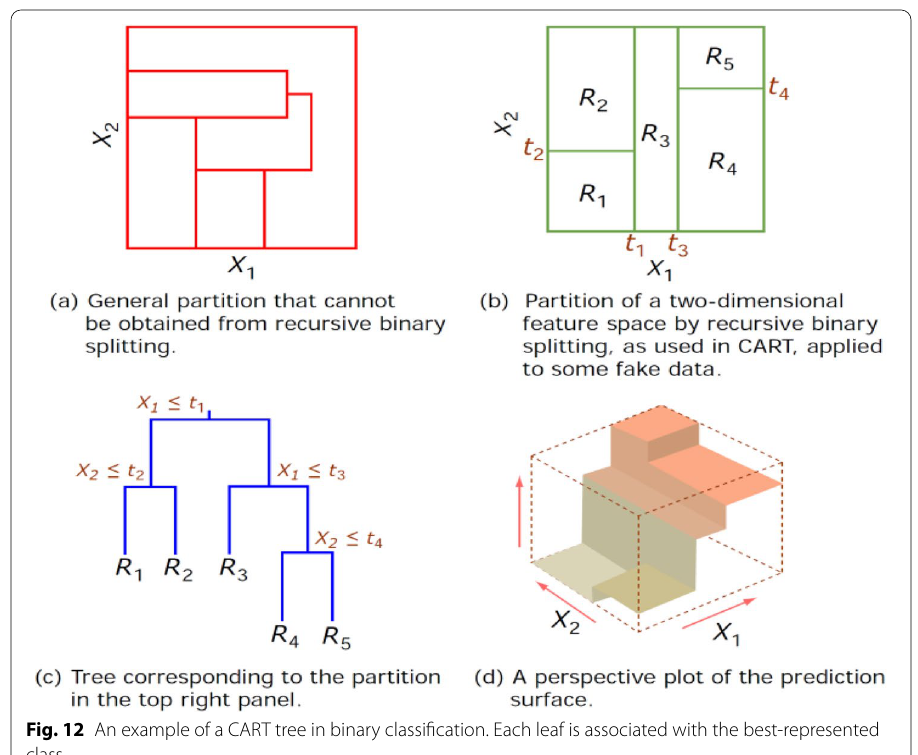
Fig. 12 An example of a CART tree in binary classification. Each leaf is associated with the best-represented